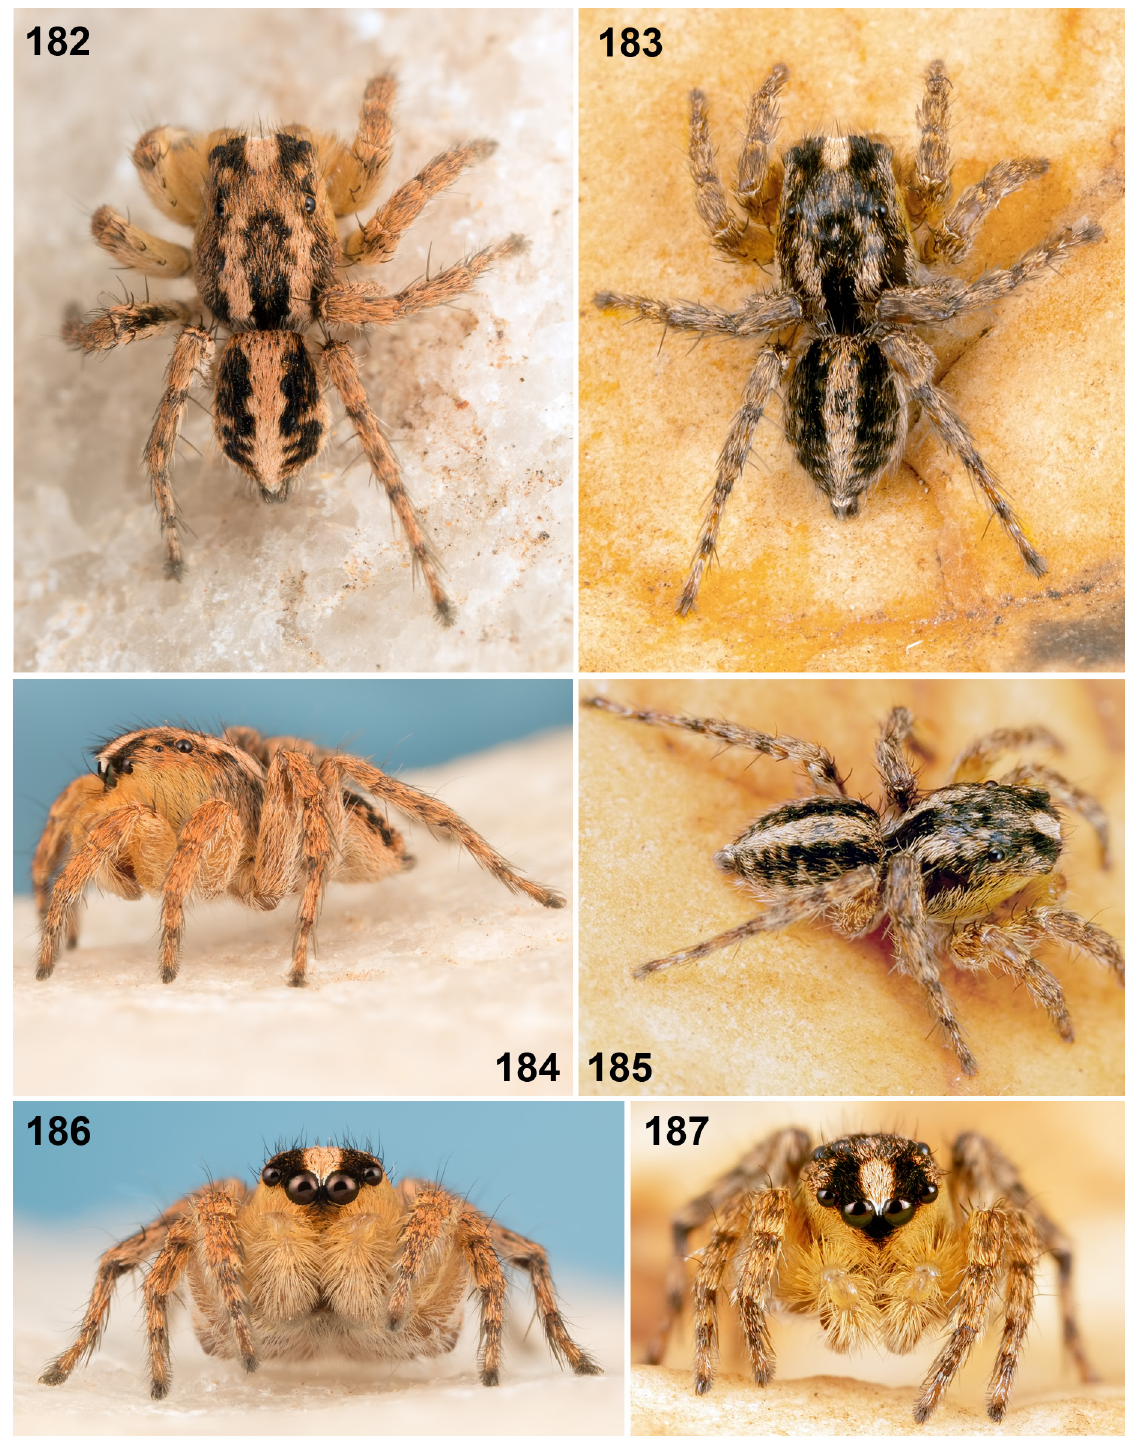
Figs 182–187. Manzuma petroae gen. et sp. nov., general appearance of live ♂ from South Africa, photos © Vida van der